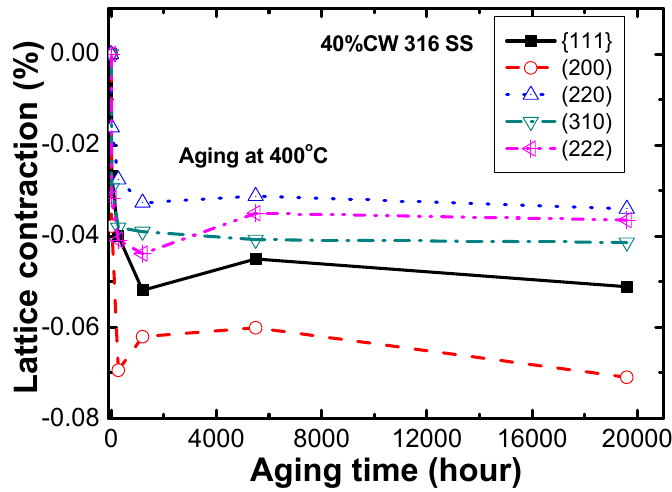
Figure 7. Lattice contractions of 40% cold worked 316 SS upon aging at 400 °C.